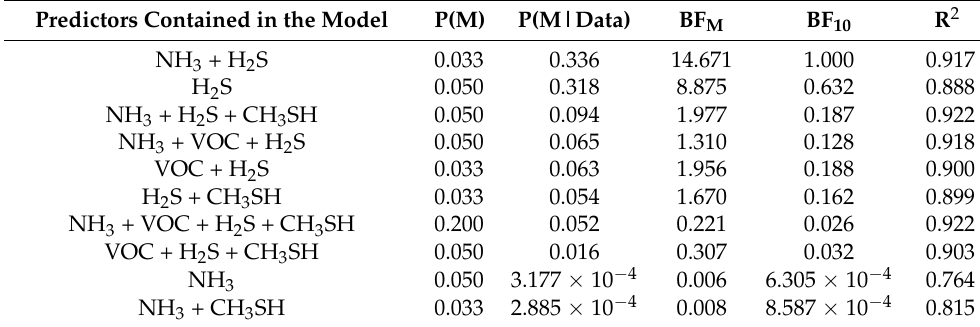
Table 5. The Bayesian linear regression model.